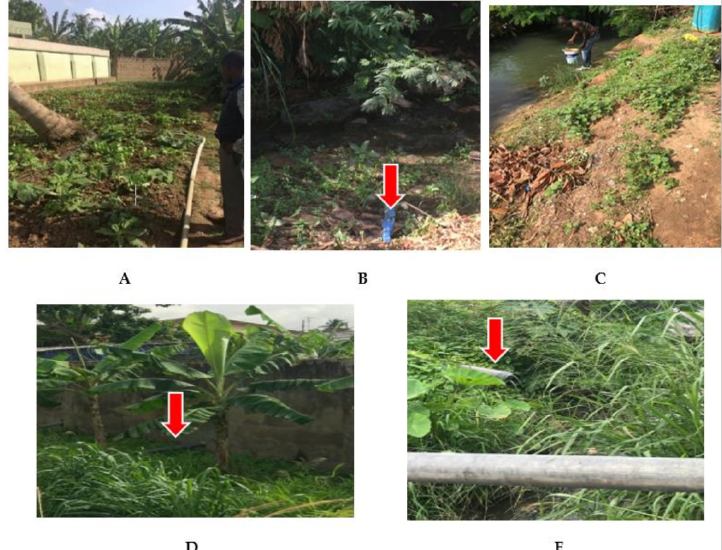
Figure 1. Onyasia stream showing a lettuce farm along the banks of the Onyasia stream ( A ) water being abstracted for irrigation ( B , C ), and domestic waste discharge into the stream ( D , E